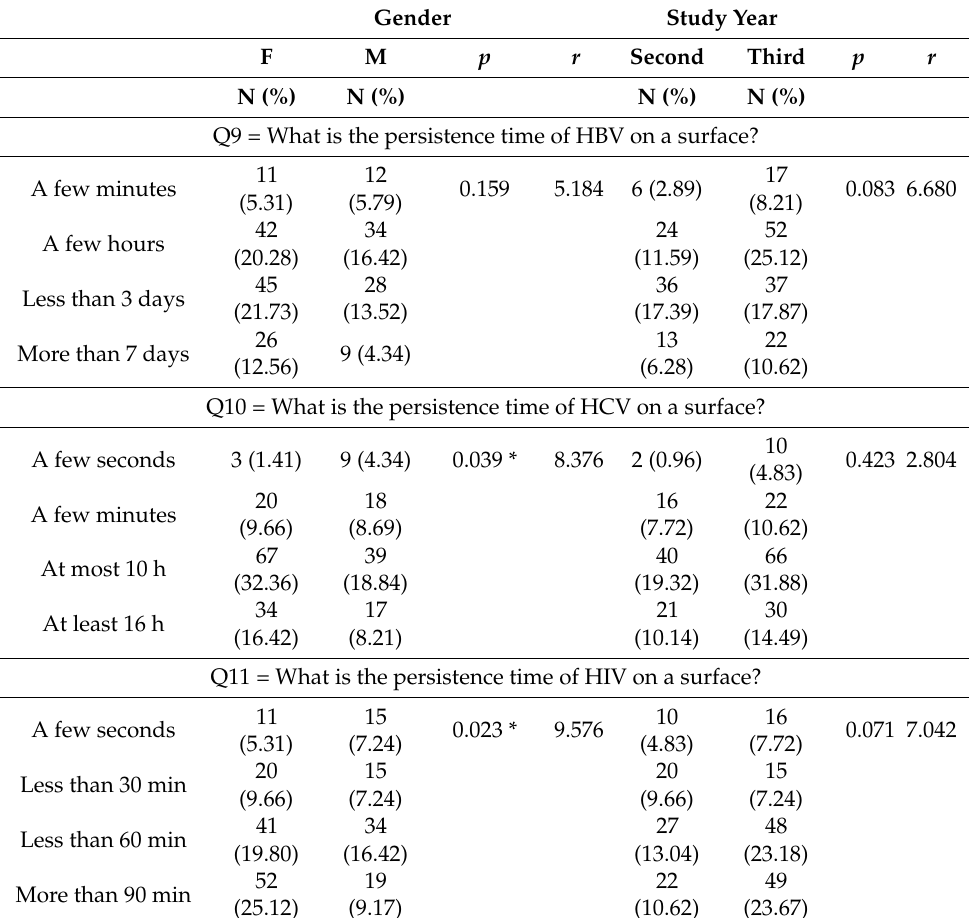
Table 2. Assessing the perception of the knowledge level about the persistence of HBV, HCV, and HIV on surfaces. Comparative data and Chi-square